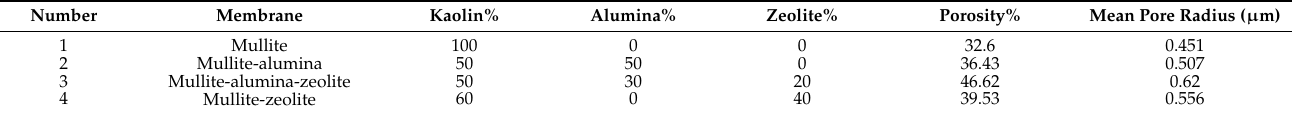
Table 4. Materials, porosity, and average pore radius for all ceramic membranes